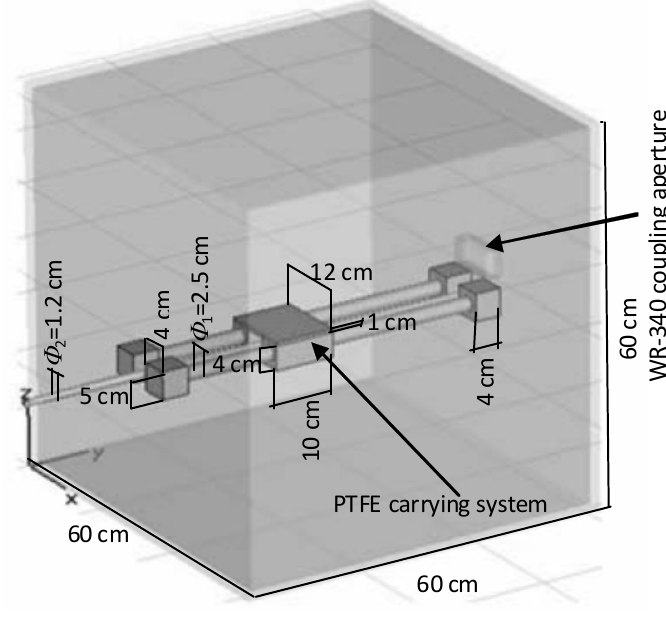
Figure 17. Scheme of the multimode microwave oven employed during optimization